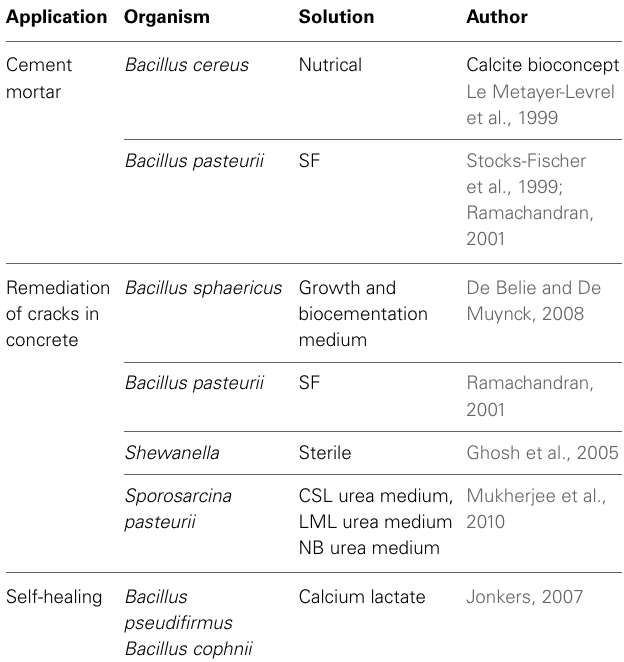
Table 2 | Overview of different applications where microbial calcite is used as biocement in cementitious